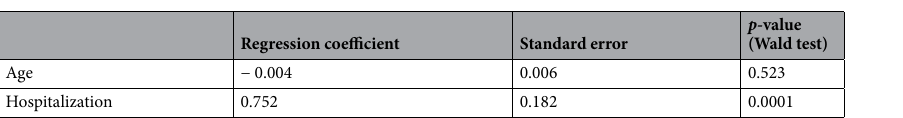
Table 2. Two-factor regression model to assess the impact of age and hospitalization on neutralizing